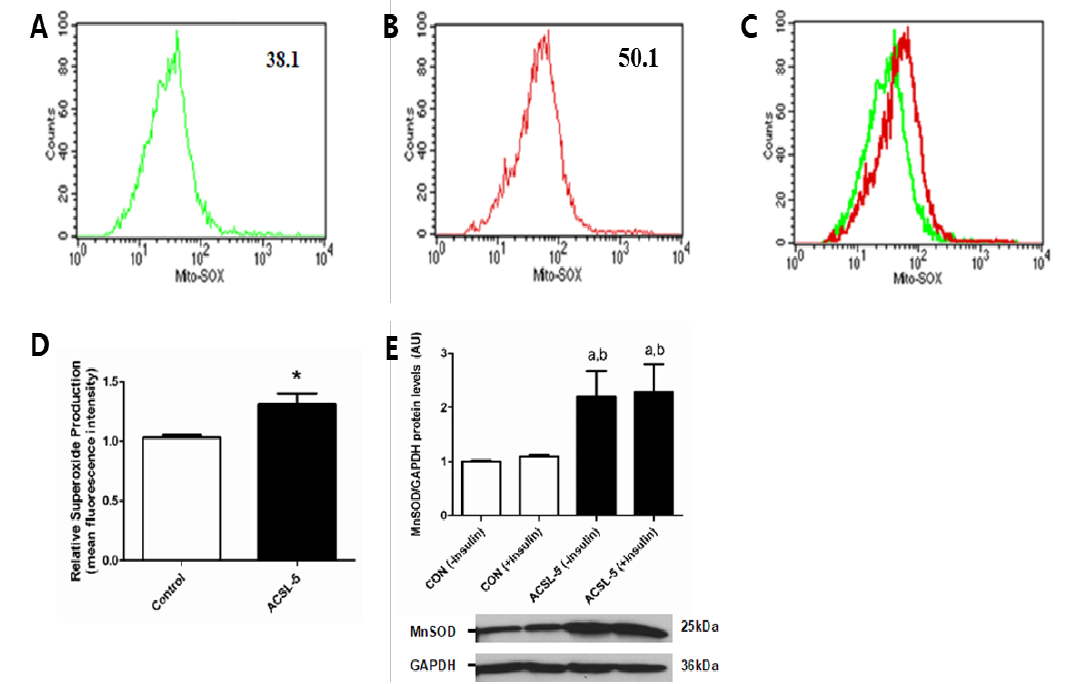
Figure 5. Effects of ACSL-5 overexpression on mitochondrial superoxide production ( A–D ) and MnSOD protein levels ( E ). Representative histograms of flow cytometry experiments were presented demonstrating mean fluorescence intensity (GFP-control: 38.1, ACSL-5 + GFP overexpression treatment: 50.1) of oxidized MitoSOX Red mitochondrial superoxide (O 2 − ) indicator from control group (only GFP transfected cells) (A), ACSL-5 + GFP transfected group (B), and overlay with control and ACSL-5 overexpressed group (C). Relative superoxide production was significantly increased in ACSL-5 overexpressed group compared with the control (D). Data are presented as mean ± SEM (n = 5). * p < 0.05 versus control. The protein levels of MnSOD (anti-oxidant enzyme) were dramatically increased by ACSL-5 overexpression (open bar, control cells; closed bar, ACSL-5 transfected cells) (E). Western blots and mean ( ± SEM) data (n = 6) normalized to GAPDH in the absence or presence of insulin treatment were presented. a p < 0.05 versus non-insulin-treated control; b p < 0.05 versus insulin-treated control (CON).